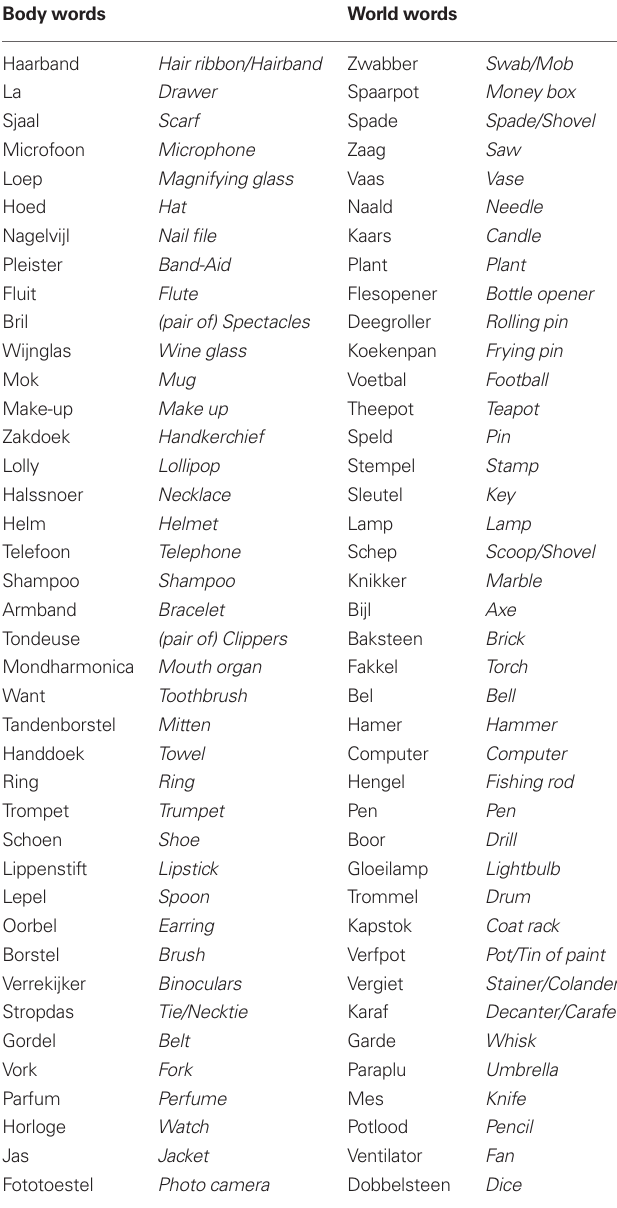
Table 1 | Dutch words associated with a movement toward the body (body words) and a movement away from the body (world words). English translations are printed in